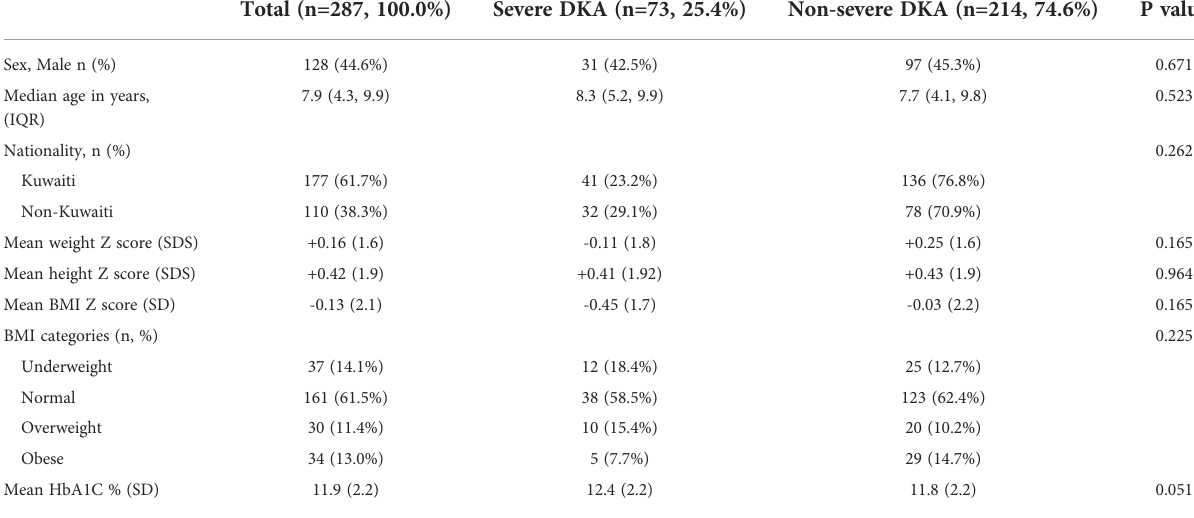
TABLE 3 Characteristics of children presenting with severe DKA vs non-severe DKA at diagnosis with T1D in Kuwait. Total (n=287, 100.0%)